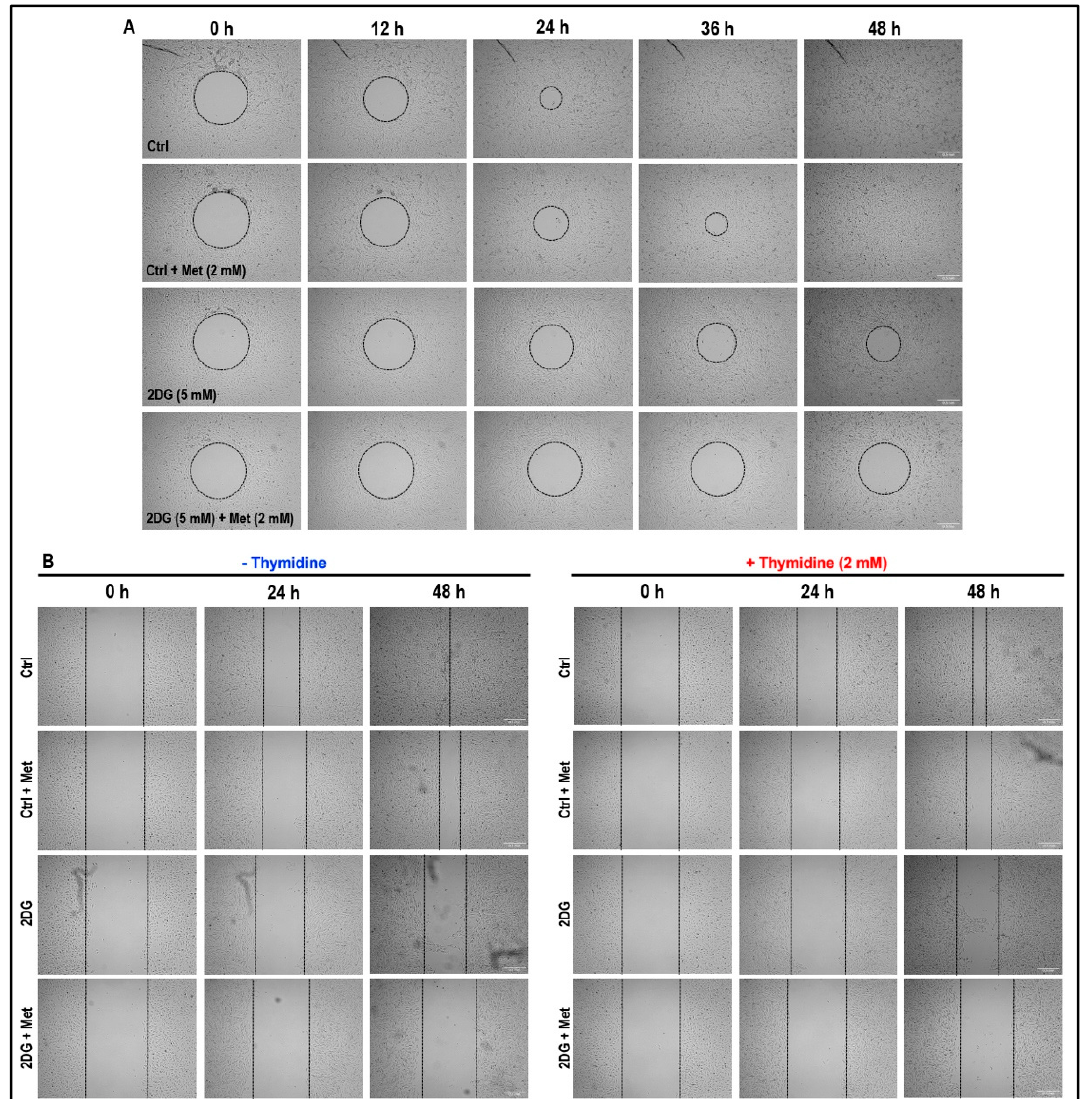
Figure 8. Effect of metformin treatment on cell migration in normal glucose- and 2DG-exposed MMECs: Representative microscopic images ( A ; from four experiments) from a ‘Radius’ cell migration assay show the rate of cell migration under the different treatment conditions at zero time (0 h) and after 12 h, 24 h, 36 h and 48 h in culture. Representative microscopic images ( B ; from three experiments) from Cytoselect cell migration assay show the rate of cell migration under the different treatment conditions in the absence or presence of thymidine (2 mM) at zero time (0 h) and after 24 h and 48 h in culture. Scale bar = 500 μ m.